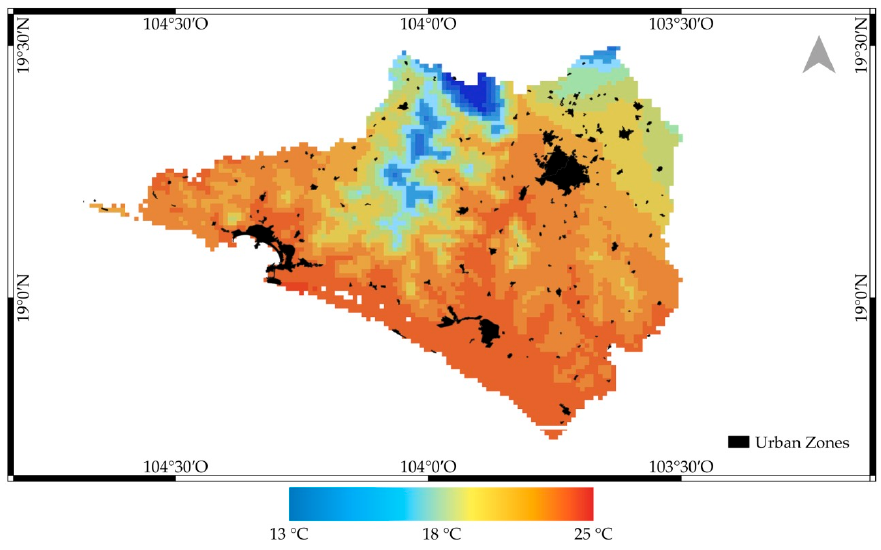
Figure 2. Average annual temperature calculation 1990–2018, Colima Mexico.